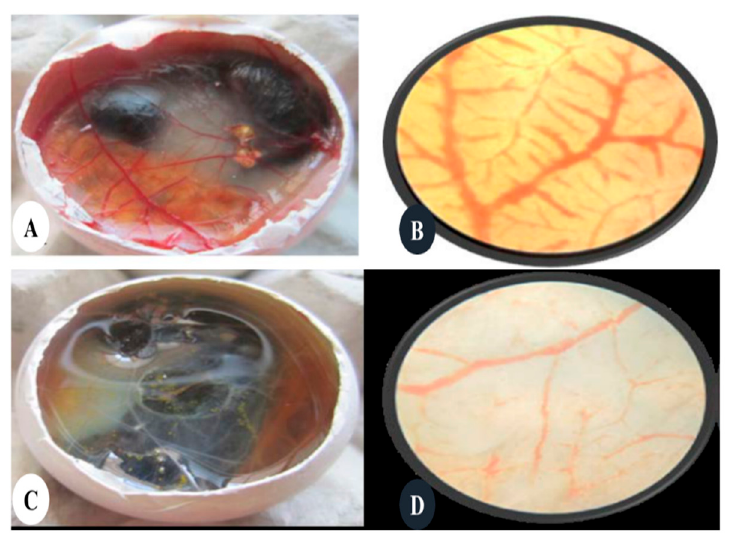
Figure 6. AgNPs were evaluated for their e ff ects on the process of angiogenesis in a chicken embryonic chorioallantoic membrane model. ( A ) control egg, ( B ) microscopic view of A, ( C ) egg treated with AgNPs, ( D ) microscopic view of ( C ) (Adapted from Khandia et al. with permission [144]).